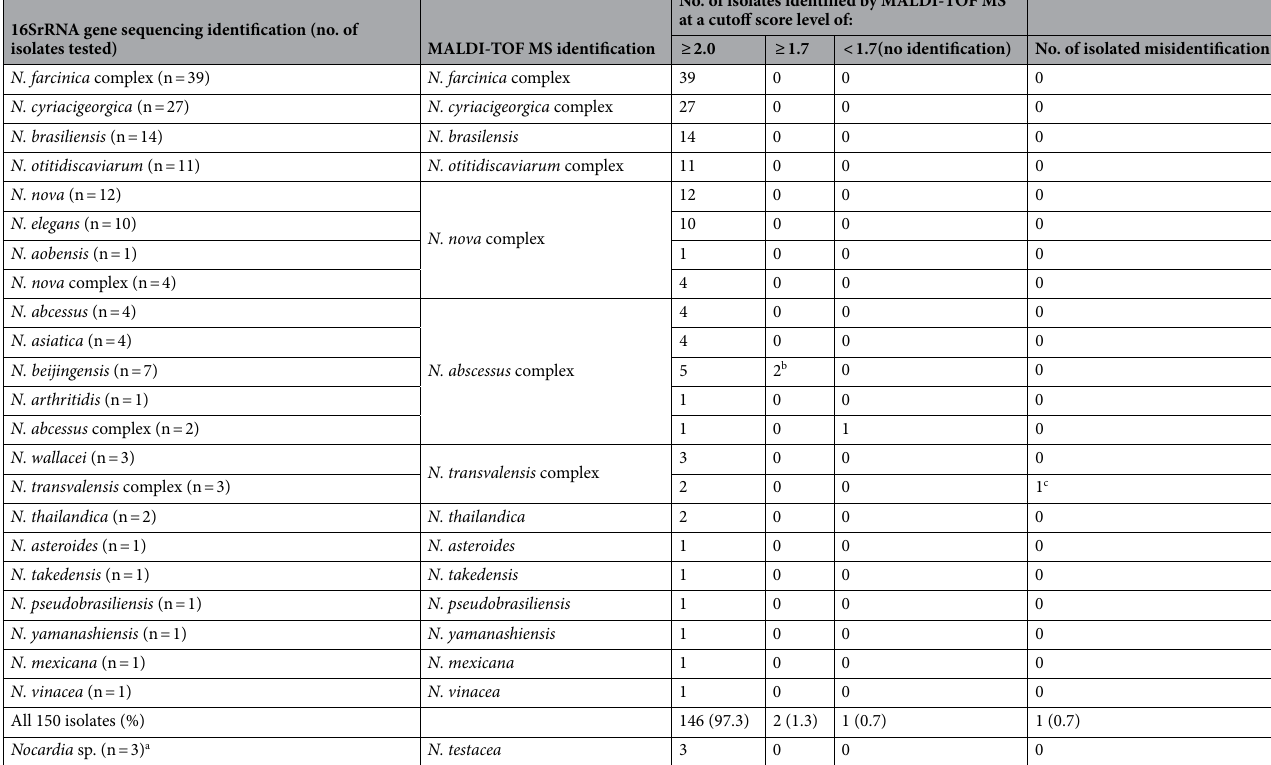
Table 1. Comparison of full-length 16SrRNA gene sequencing and MALDI-TOF MS identification for 153 Nocardia spp. isolates using the manufactuer’s library combined with a custom library. a 2/3 isolates were identified as N. testacea / N. sienata , and 1/3 isolates was identified as N. testacea / N. flavorosea / N. sienata / N. rhamnosiphila . b Two isolates were identified as N. araoensis with scores of 1.91 and 1.99, respectively. c misidentified as N. brasilliensis with a score of